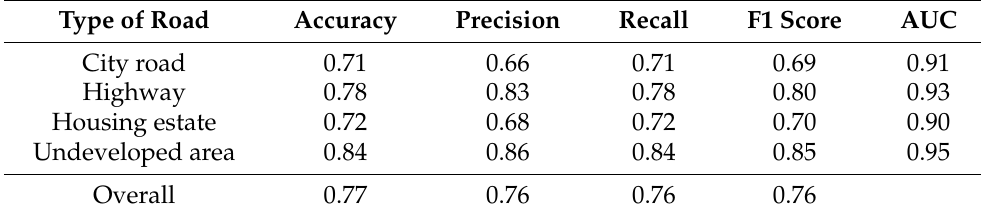
Table A3. Evaluation metrics of the neural network classifier on the test